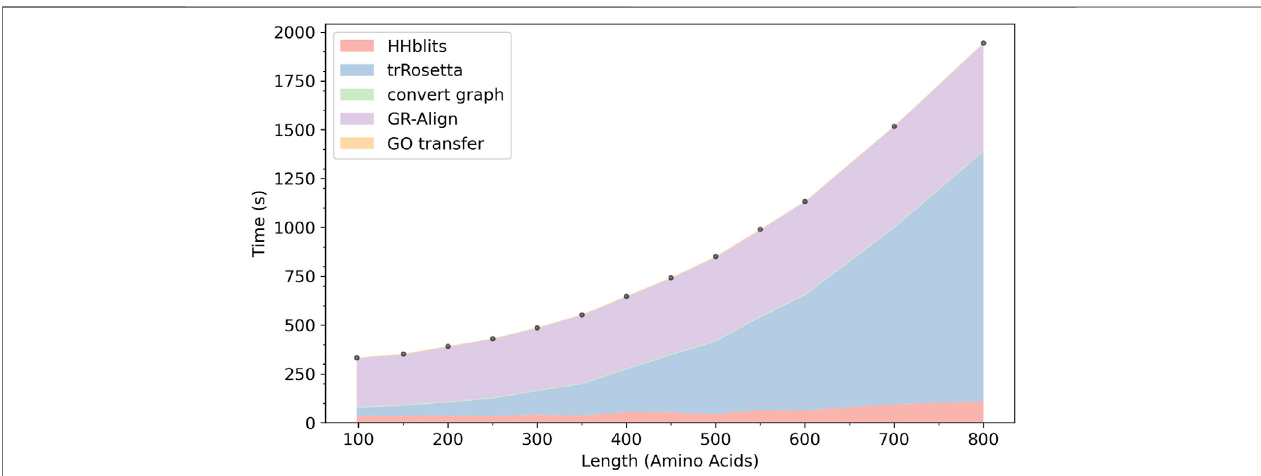
FIGURE 9 | The cumulative computational time of ContactPFP. The time is decomposed into fi ve steps: The database search with HHblits, the distance map prediction by trRosetta, converting a predicted distance map to a contact graph, contact graph comparison against the reference database by GR-Align, constructing GOtermlist fromahitlist,arereported.Thetimesarereportedinthewall-clocktime (seconds). AllcomputationswereperformedonCPU, 2AMDEPYC7252cores(16 coresin total) with 128GB RAM. The following 13proteins were used,whichhave alength between 100and 800amino acids. The length ofeach protein isshown in theparenthesis.P0CM71(98),P9WF14 (150),P69162 (200), B1W5S5 (250), A1YG61(300), Q6Q972 (350), Q550G0 (400), C5A1K9 (450),Q00456 (500),A1DHW5 (550), A5DX93 (600), Q96QV1 (700), and Q54WZ0 (800). These proteins were chosen because they hit the same number of sequences, 500 (± 10) sequences, by